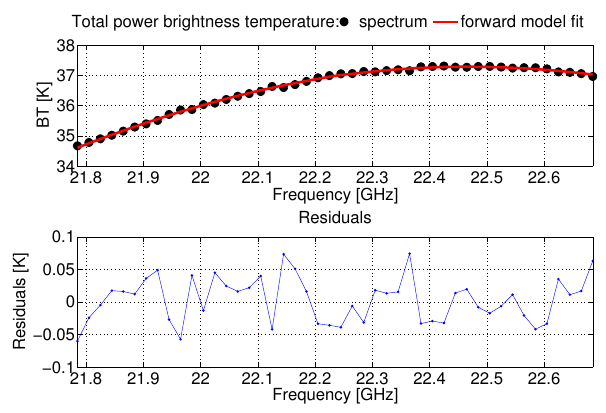
Fig. 4. Total power brightness temperature spectrum of MIAWARA (2h average) compared with the forward model calculation (top plot) and residuals (bottom